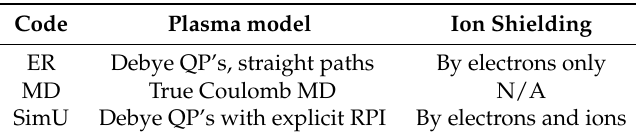
Table 5. Details of participating simulations. In all three codes, the motion of all plasma particles—electrons and ions—is